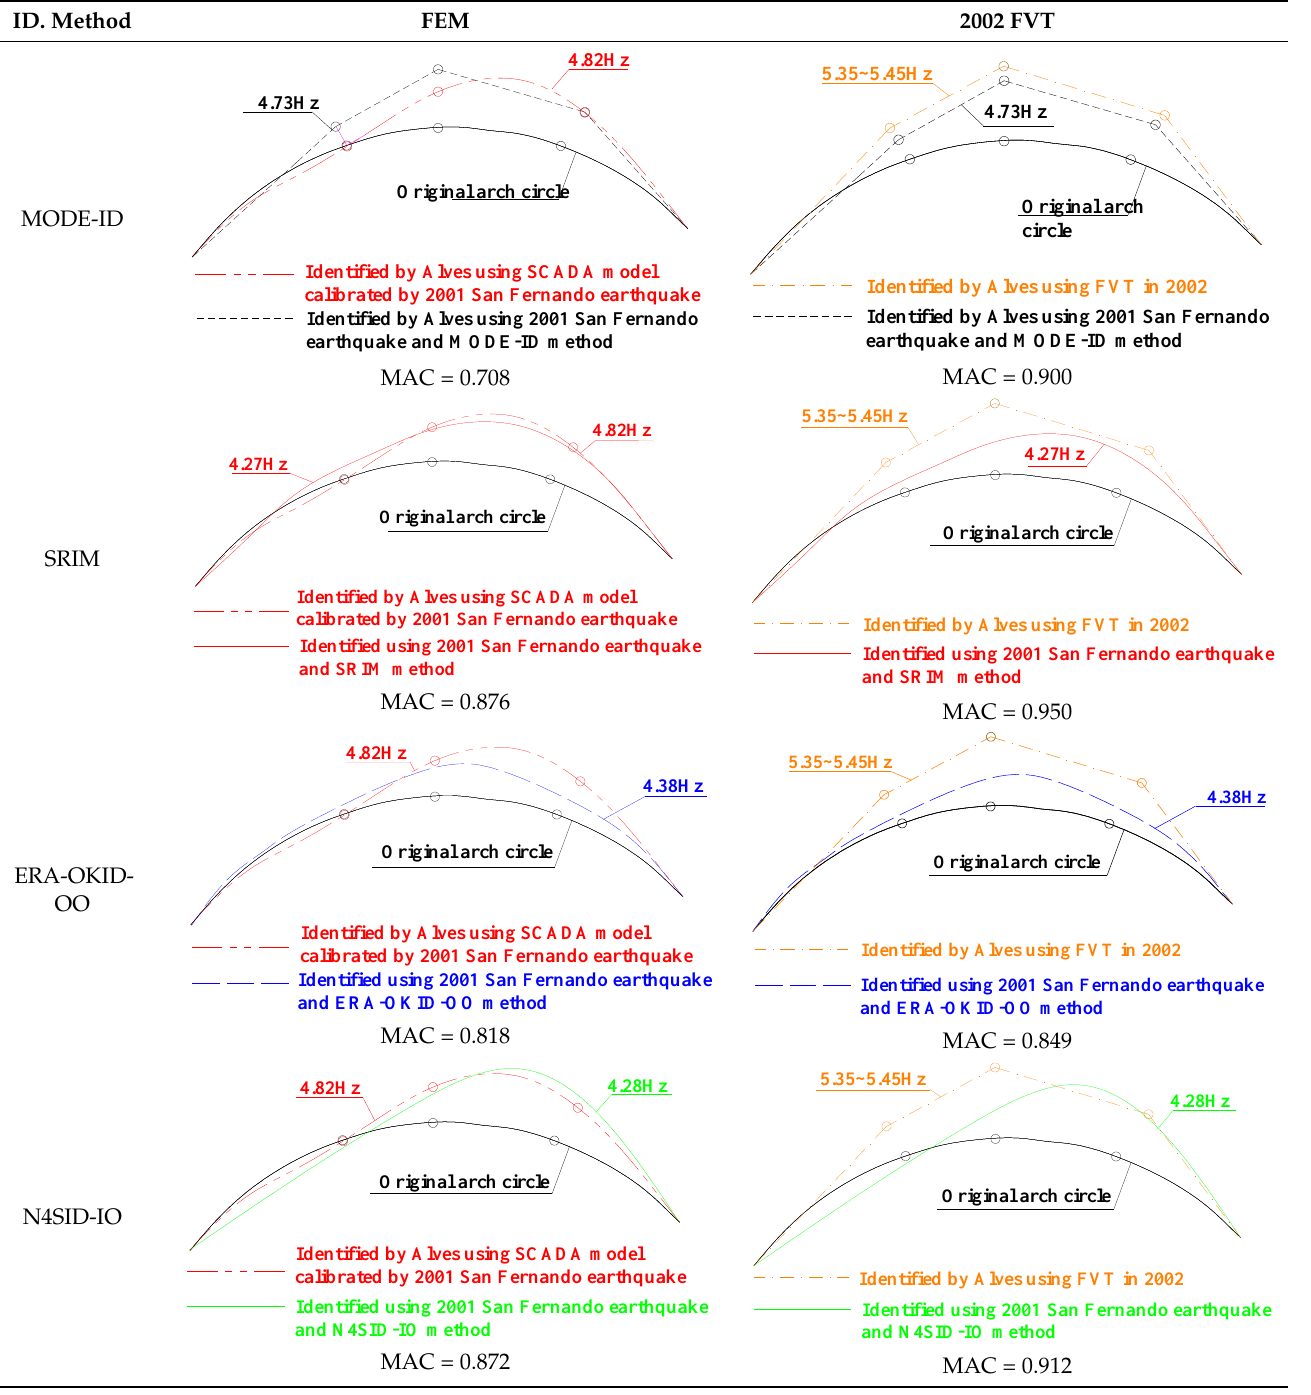
ure 10. The errors between the vibration modes obtained by these four modal identifica- tion methods were relatively small, which reveals that the system identification results of the vibration modes of the various methods can be verified by each other.